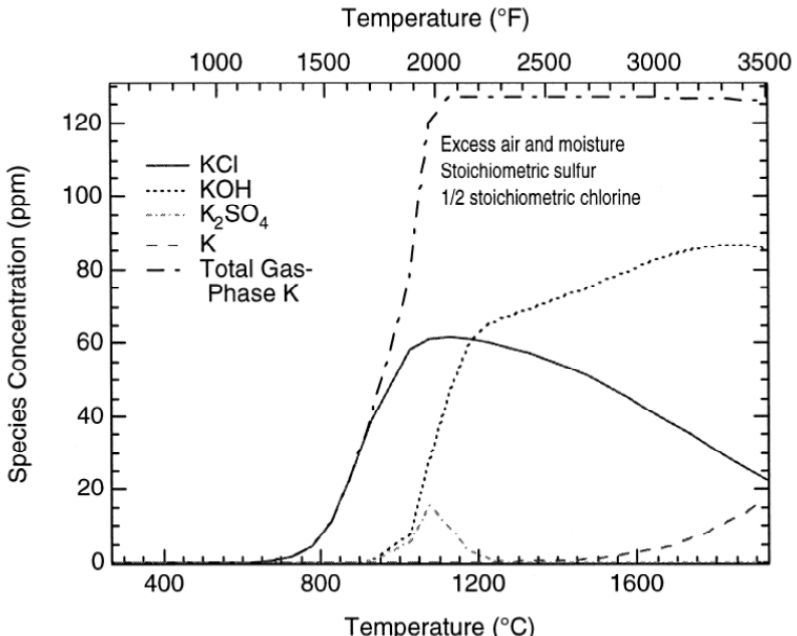
Figure 3. Equilibrium concentrations in gas phase for the major potassium containing species present in biomass fuel under typical biomass combustion conditions [11].